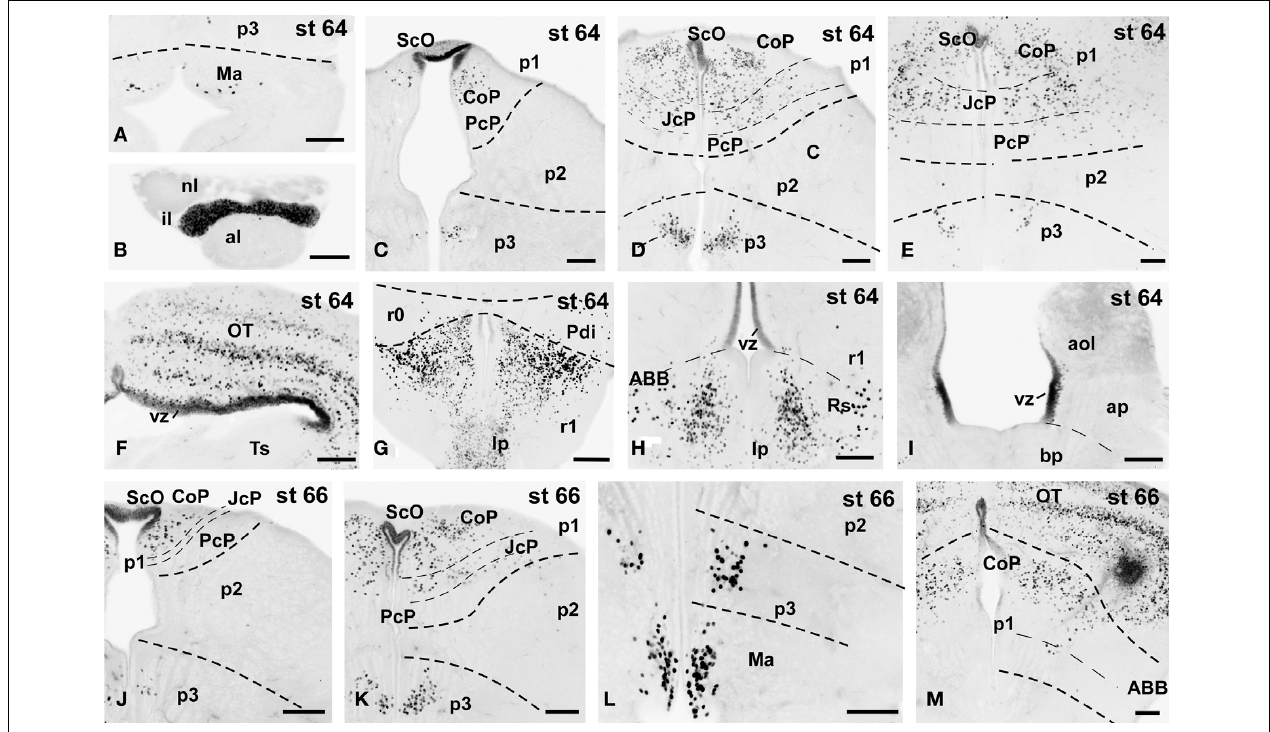
FIGURE 7 | Photomicrographs of single-stained transverse (A–M) sections through the brain of Xenopus laevis showing the localization of Pax7 cells. Different stages (indicated in the upper right corner of each photomicrograph) corresponding to tadpoles at the climax of the